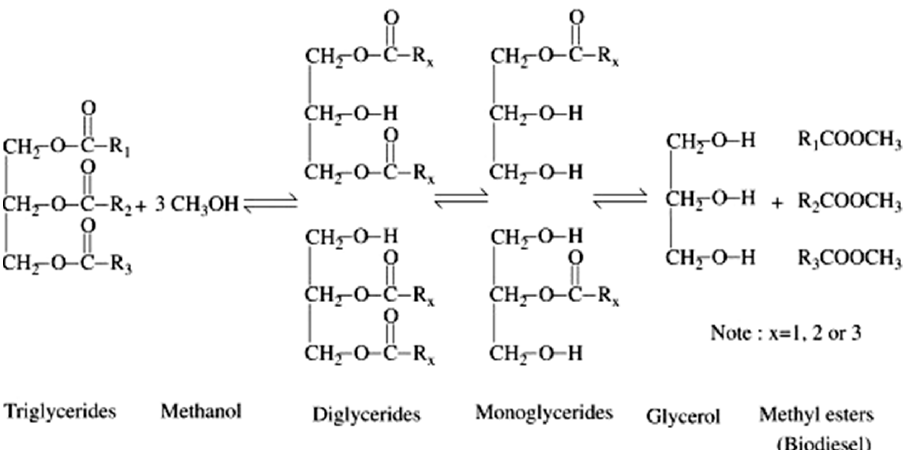
Figure 2. General representation of the catalytic transesterification process of triglycerides with methanol to produce biodiesel.